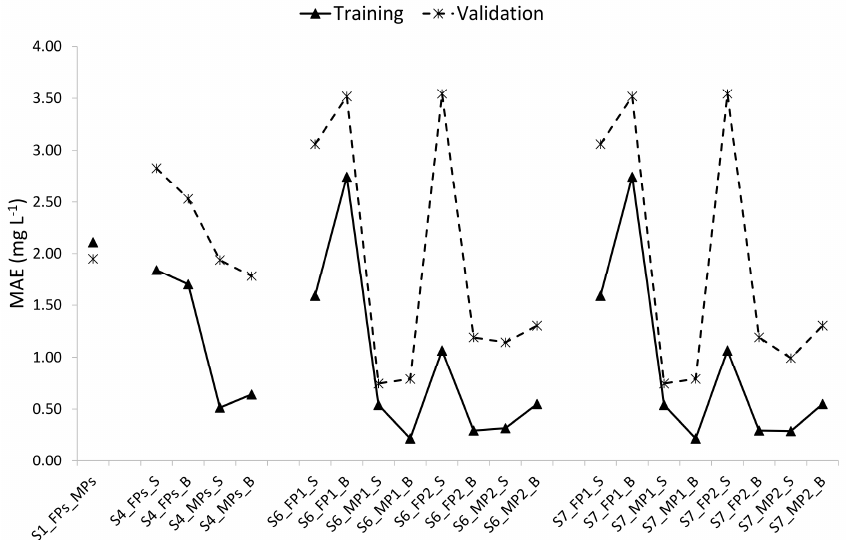
Figure 4. Mean absolute error of the models with the best predictive performance in different data partitioning and cross-validation strategies. Among seven strategies, only four strategies (S1, S4, S6 and S7) resulted in high predictive performing models, which were pond and depth-specific. FP = Facultative pond; MP = Maturation pond; S = Surface; and B = Bottom.